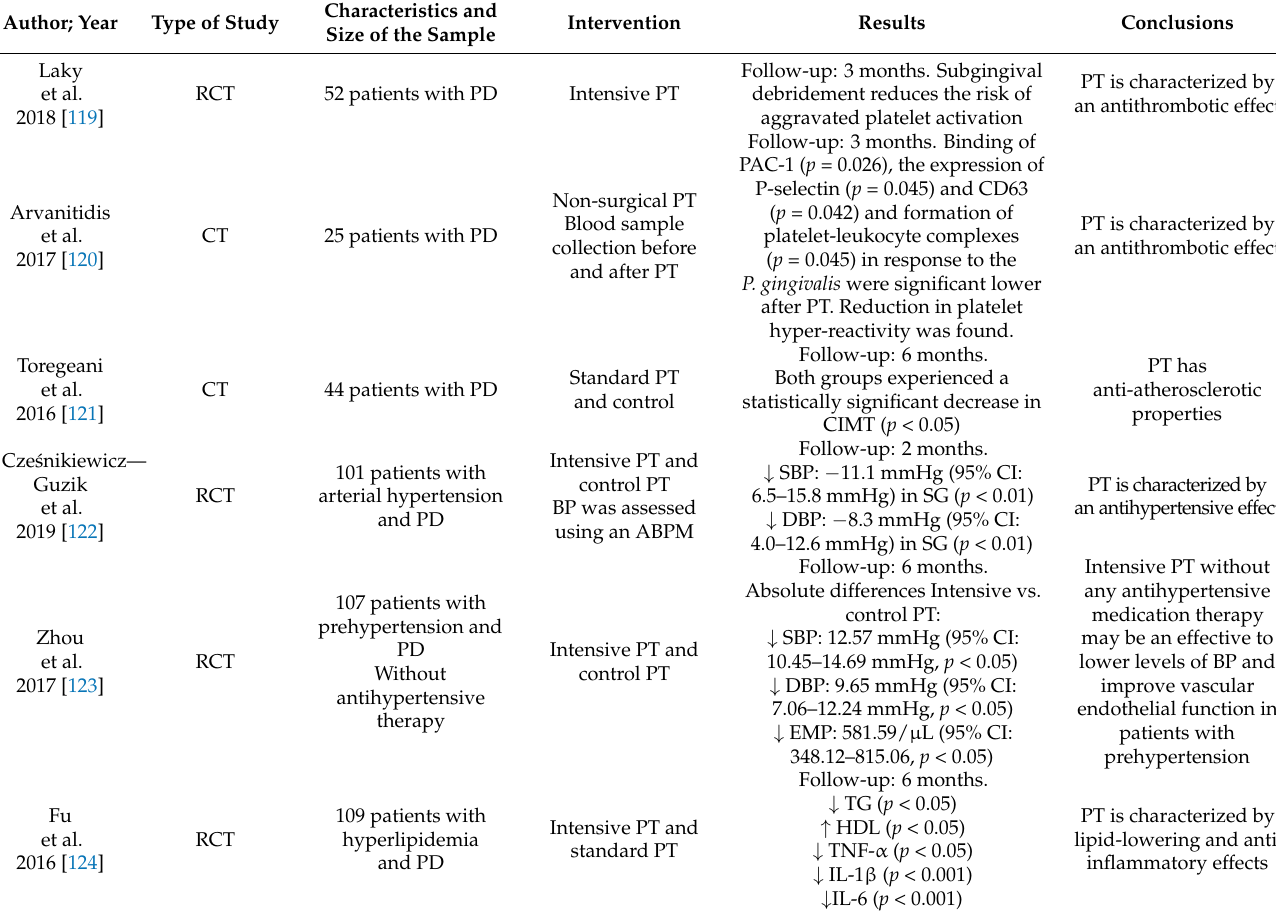
Table 1. Selected intervention studies assessing the effect of periodontal disease treatment on cardiovascular parameters. Abbreviations: RCT (randomized control trial); PD (periodontal disease); PT (periodontal therapy); CT (clinical trial); PAC-1 (first procaspase activating compound); CIMT (carotid intima-media thickness); BP (blood pressure); ABPM (ambulatory blood pressure monitoring); SBP (systolic blood pressure); DBP (diastolic blood pressure); EMP (endothelial microparticles);